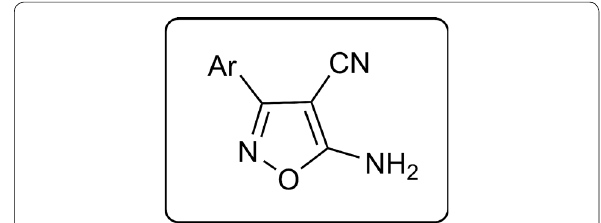
Fig. 1 Schematic representation of isoxazole skeletons with antimicrobial and antioxidant activity